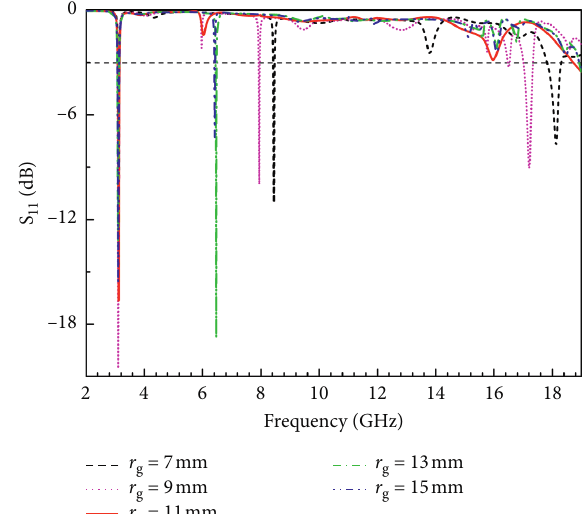
Figure 6: Simulated S